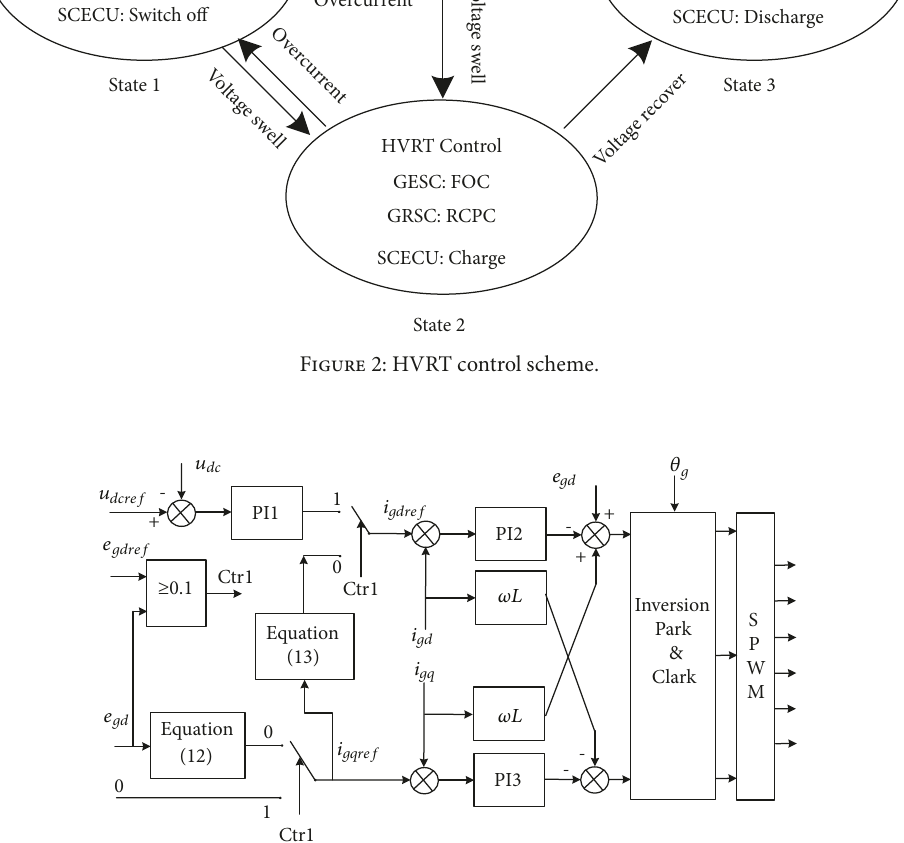
Figure 3: Control scheme of